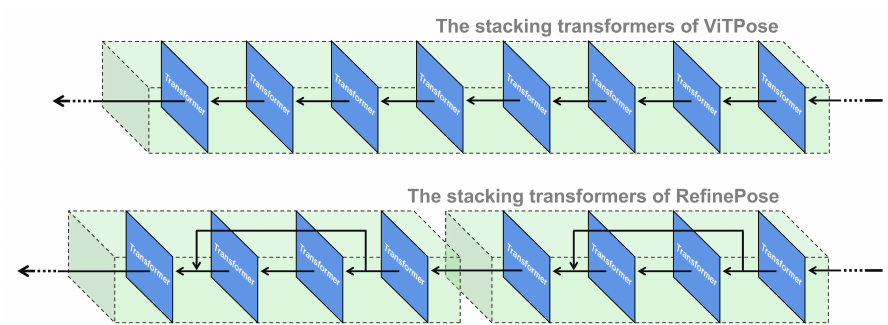
Figure 5. Comparison of the stacking transformers between RefinePose and